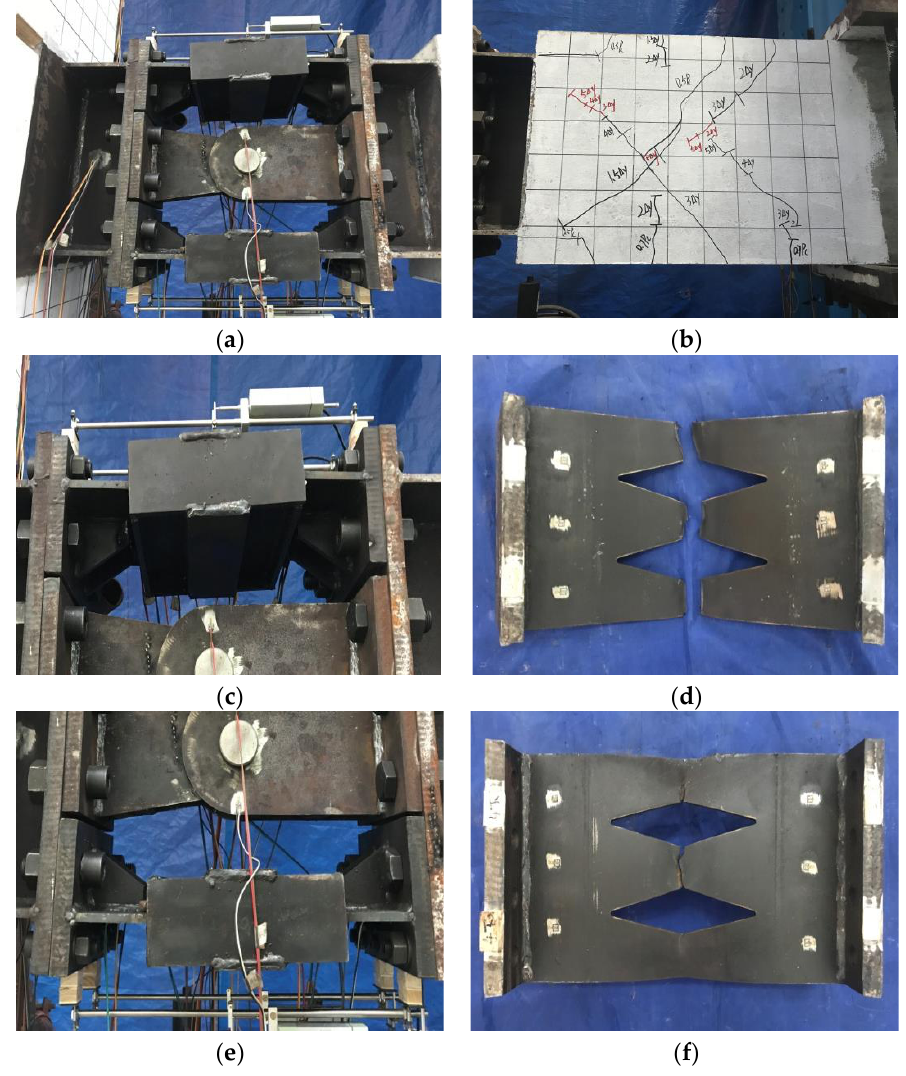
Figure 9. ( a ) Failure mode of the energy-dissipating hinge; ( b ) crack development in concrete; ( c ) failure mode of the upper connector; ( d ) failure mode of the upper steel plate; ( e ) failure mode of lower connector; ( f ) failure mode of the lower steel plate.